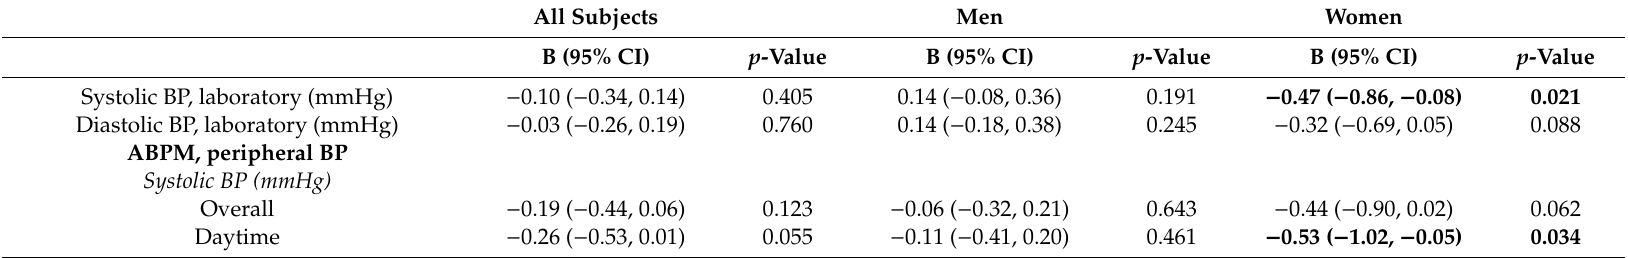
Table 5. Multivariable analyses of the association of unprocessed / minimally processed food (MPF) consumption and blood pressure (BP) and vascular function, adjusted for sex, age, and